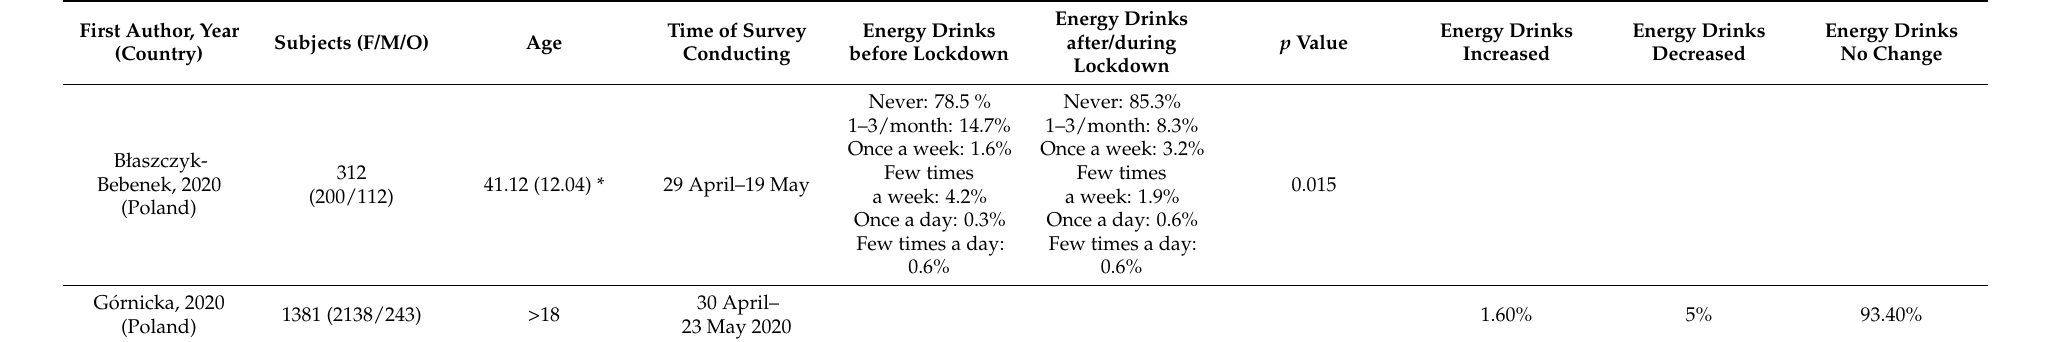
Table 2. Characteristics of included studies for energy drinks consumption and relevant info before and after/during